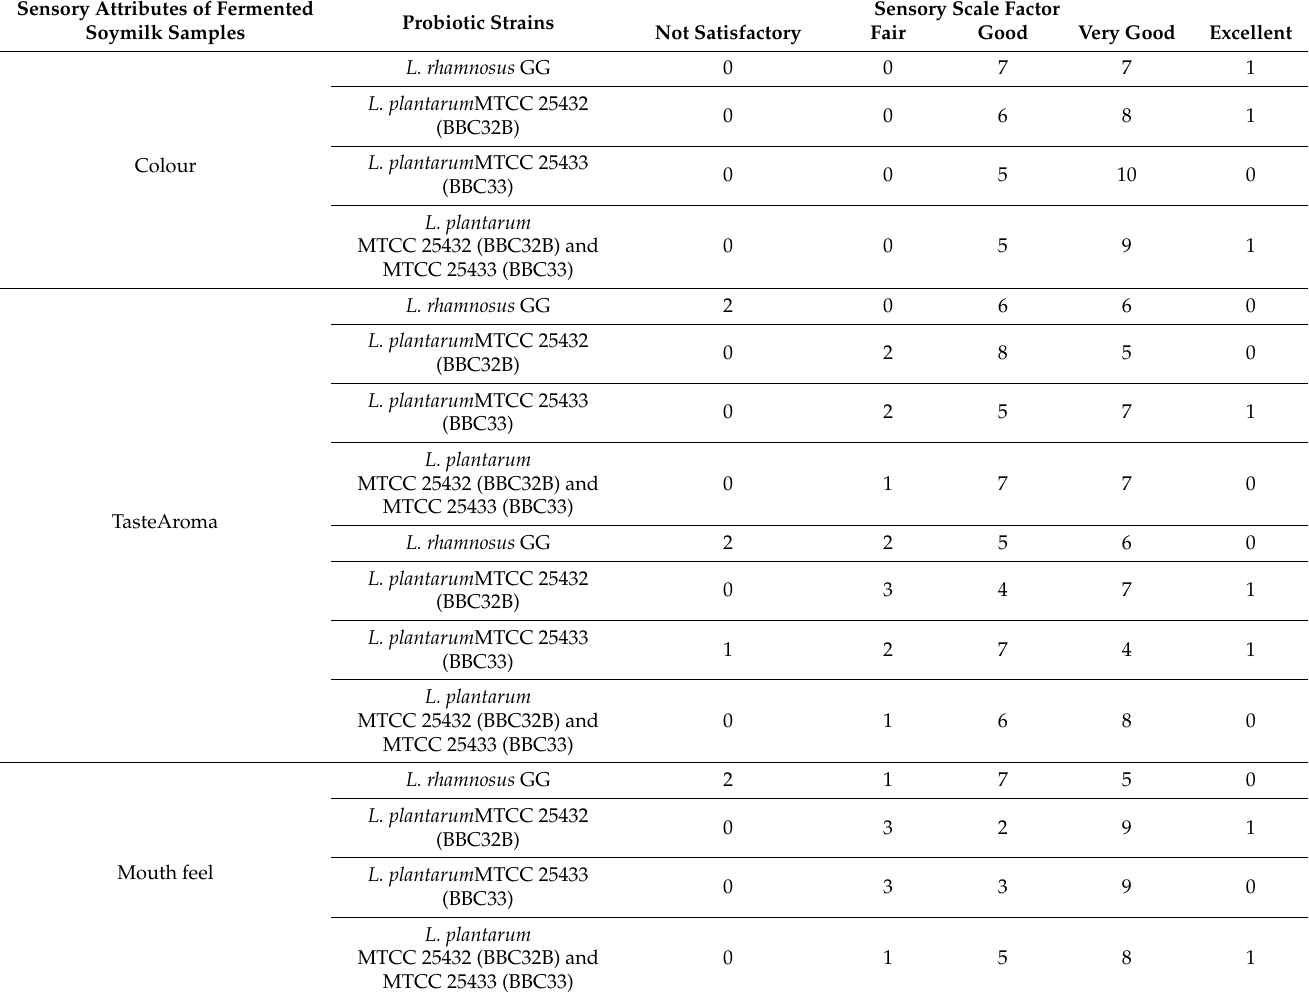
Table 5. Sensory scores of the soycurd produced by different